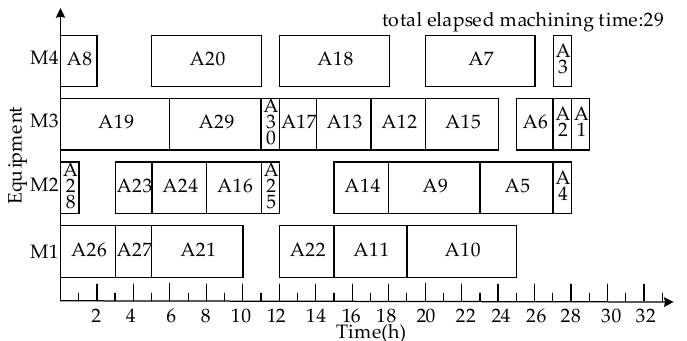
Figure 8. Gantt chart of scheduling A using DCPM.